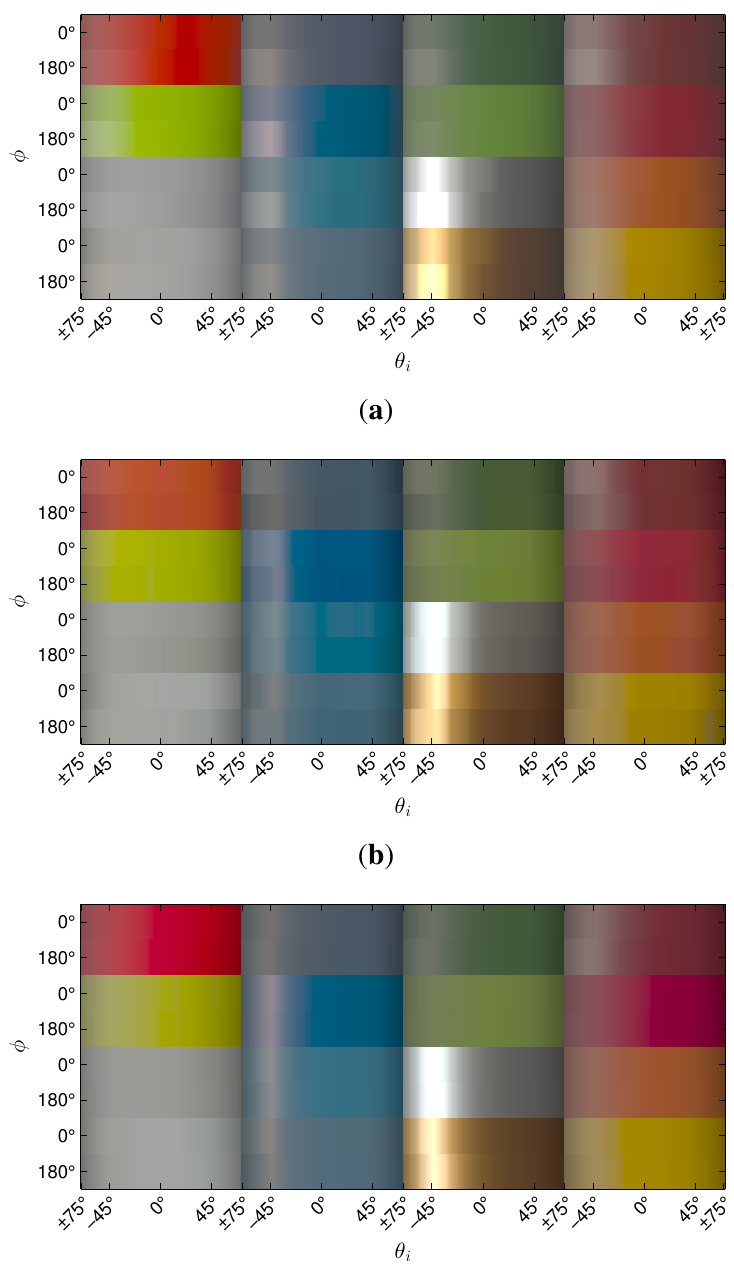
Figure 18. Reflectance measurements of the hand-made material chart (shown in Figure 3). All images depict measurements taken at the fixed camera elevation of θ o = 45 ◦ . The reflectance is visualized as sRGB color values. For the purpose of visualization, the high dynamic range values are tonemapped with a gamma of 3. Measurement values are taken for a semi-circle of illumination directions with θ i azimuthal view and light direction angles φ i = φ o marker is divided in two rows, corresponding to φ = 0 ◦ and φ = 180 ◦ . The illumination direction θ i is varied along the X -axis. Almost all materials, especially gold and silver, exhibit a specular highlight in the perfect mirror direction at θ i = to Figure 19 for polar plots of the depicted values. ( a ) gonioreflectometer; ( b ) Dome 1; ( c ) Dome